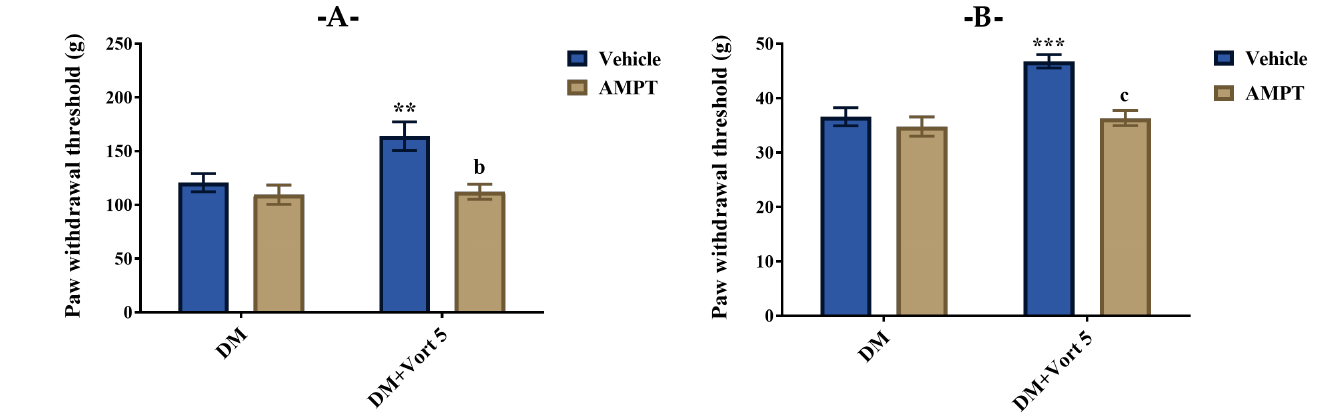
Figure 6. The effects of AMPT pre-treatment on antihyperalgesic ( A ) and antiallodynic ( B ) responses induced by the administration of 5 mg/kg vortioxetine in the Randall–Selitto and Dynamic plantar tests, respectively. Values are given as mean ± S.E.M. Significant difference against vehicle-administered diabetic group (DM) ** p < 0.01; *** p < 0.001; significant difference against vortioxetine-administered diabetic group (DM + Vort 5) b p < 0.01; c p < 0.001. Two-way ANOVA, post hoc Bonferroni multiple comparison test, n = 8.